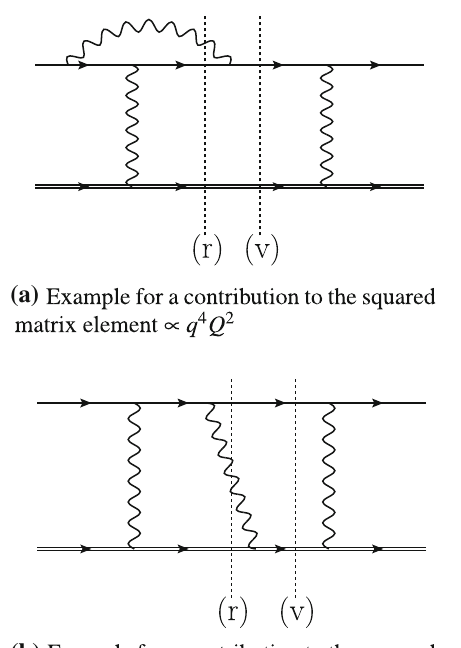
Fig. 4 Examples of NLO QED contributions to M ( 0 ) (v). Analogous muonic contributions proportional to q 2 Q 4 are